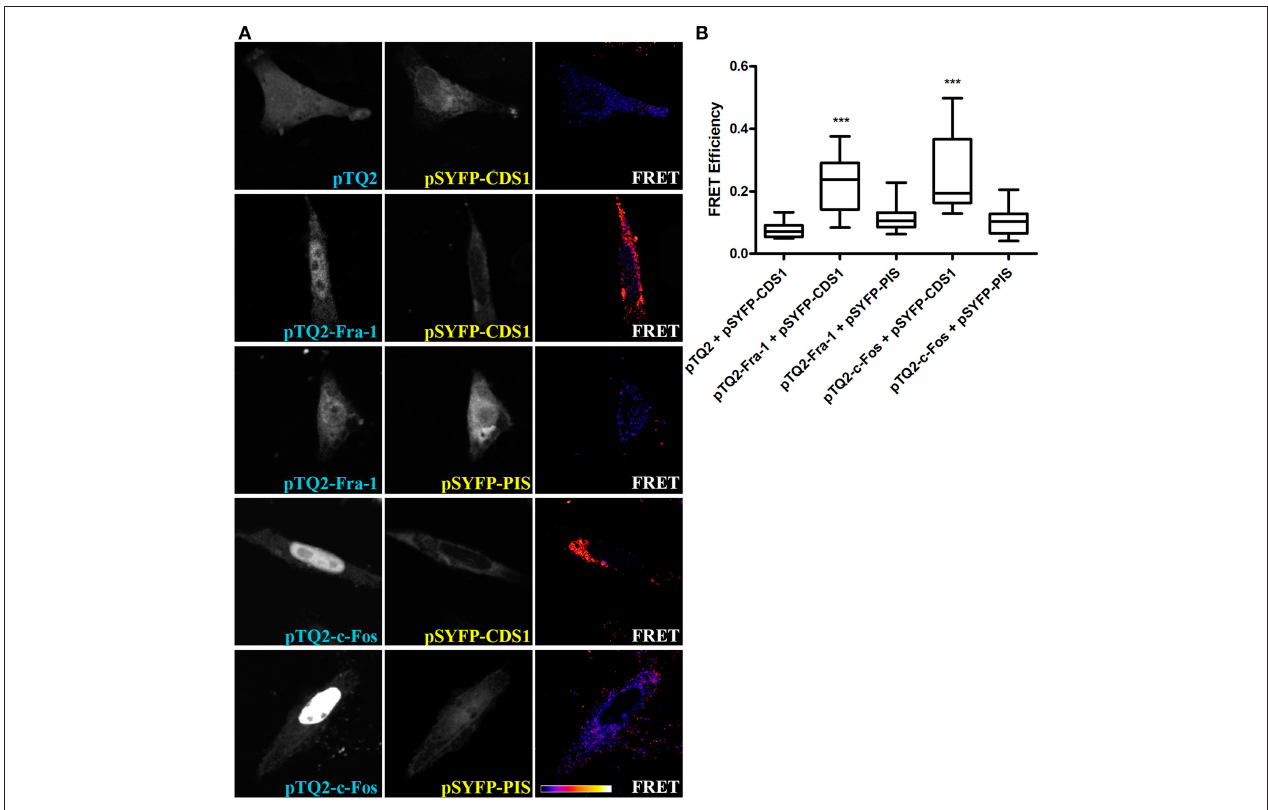
FIGURE 2 | Fra-1 and c-Fos physically associate with CDS1 but not with PIS. (A) MDA-MB231 cells were co-transfected to express pTQ2 and pSYFP-CDS1 (first row) as a negative control, pTQ2-Fra-1 and pSYFP-CDS1 (second row), pTQ2-Fra-1 and pSYFP-PIS (third row), pTQ2-c-Fos and pSYFP-CDS1 (fourth row) or pTQ2-c-Fos and pSYFP-PIS (last row), and examined by confocal microscopy; for FRET efficiency quantification, the sensitized emission method was applied. The first column shows tagged Fra-1 or c-Fos expression, the second, the expression of the tagged enzyme and the third column shows FRET efficiency; the scale bar on the bottom row shows an increasing FRET efficiency scale from violet (no FRET) to white. (B) FRET efficiency quantification is depicted as boxplot graphs representing the medians (central horizontal bars), the 25–75th percentile interquartile range (box limits), and the lowest and highest values (whiskers). *** p < 0.001 (Kruskal-Wallis test, Dunn’s post-test). One representative experiment of three performed that gave essentially the same results, is shown.